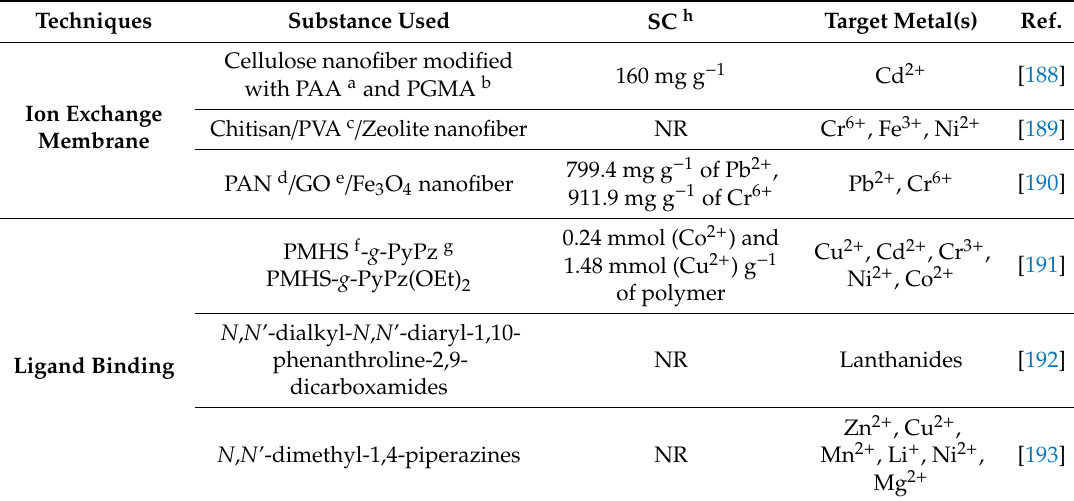
Table 8. Ion exchange and ligand binding techniques for metal ion